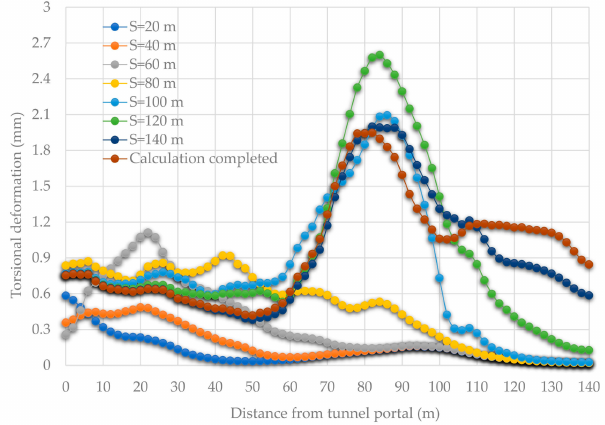
Figure 21. Torsional deformation of the middle partition